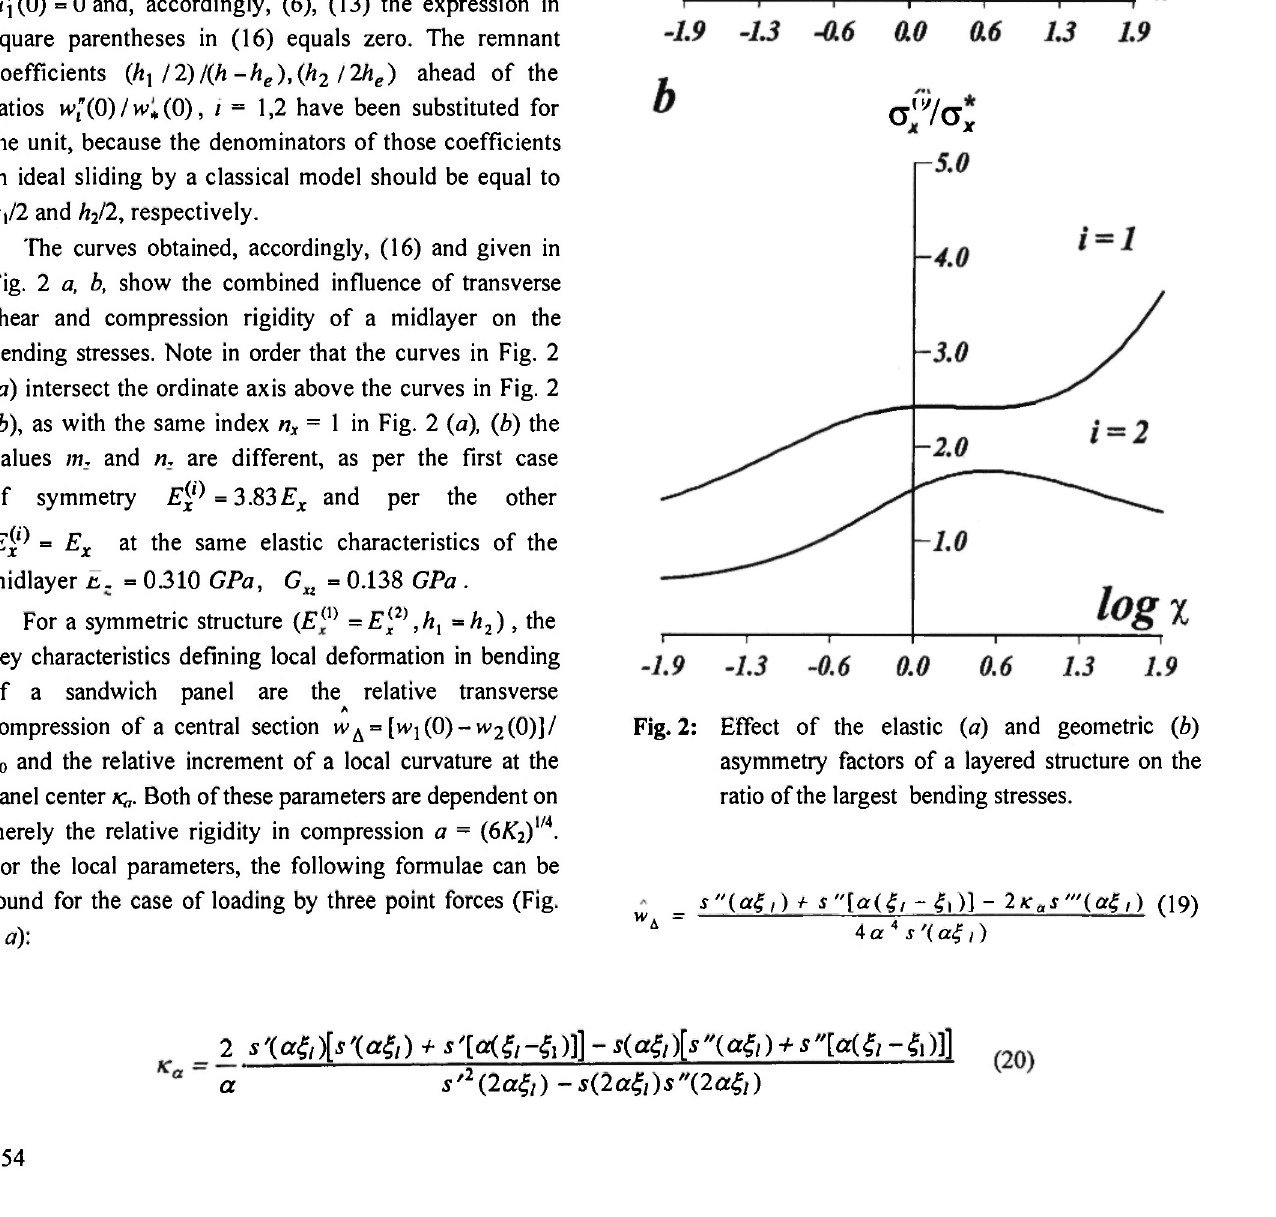
Fig. 2: Effect of the elastic (α) and geometric (b) asymmetry factors of a layered structure on the ratio of the largest bending